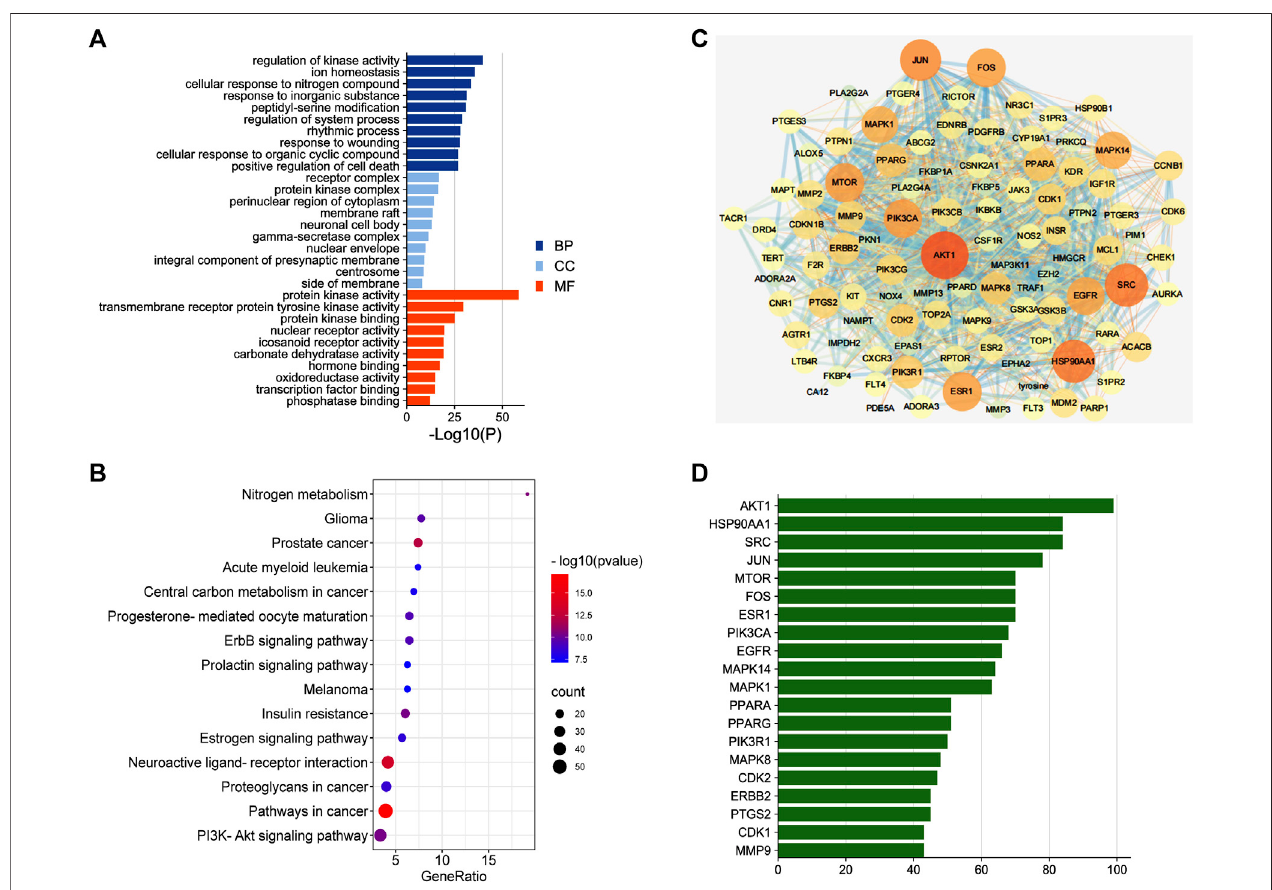
FIGURE 4 | The second dimension-network pharmacology study of the detected ingredients of FSGD in CRF. (A) GO enrichment analysis. (B) The top 15 KEGG pathway enrichment dot-plot diagram. (C) The construction of protein-protein interaction network. (D) Common Targets-bar plot diagram.